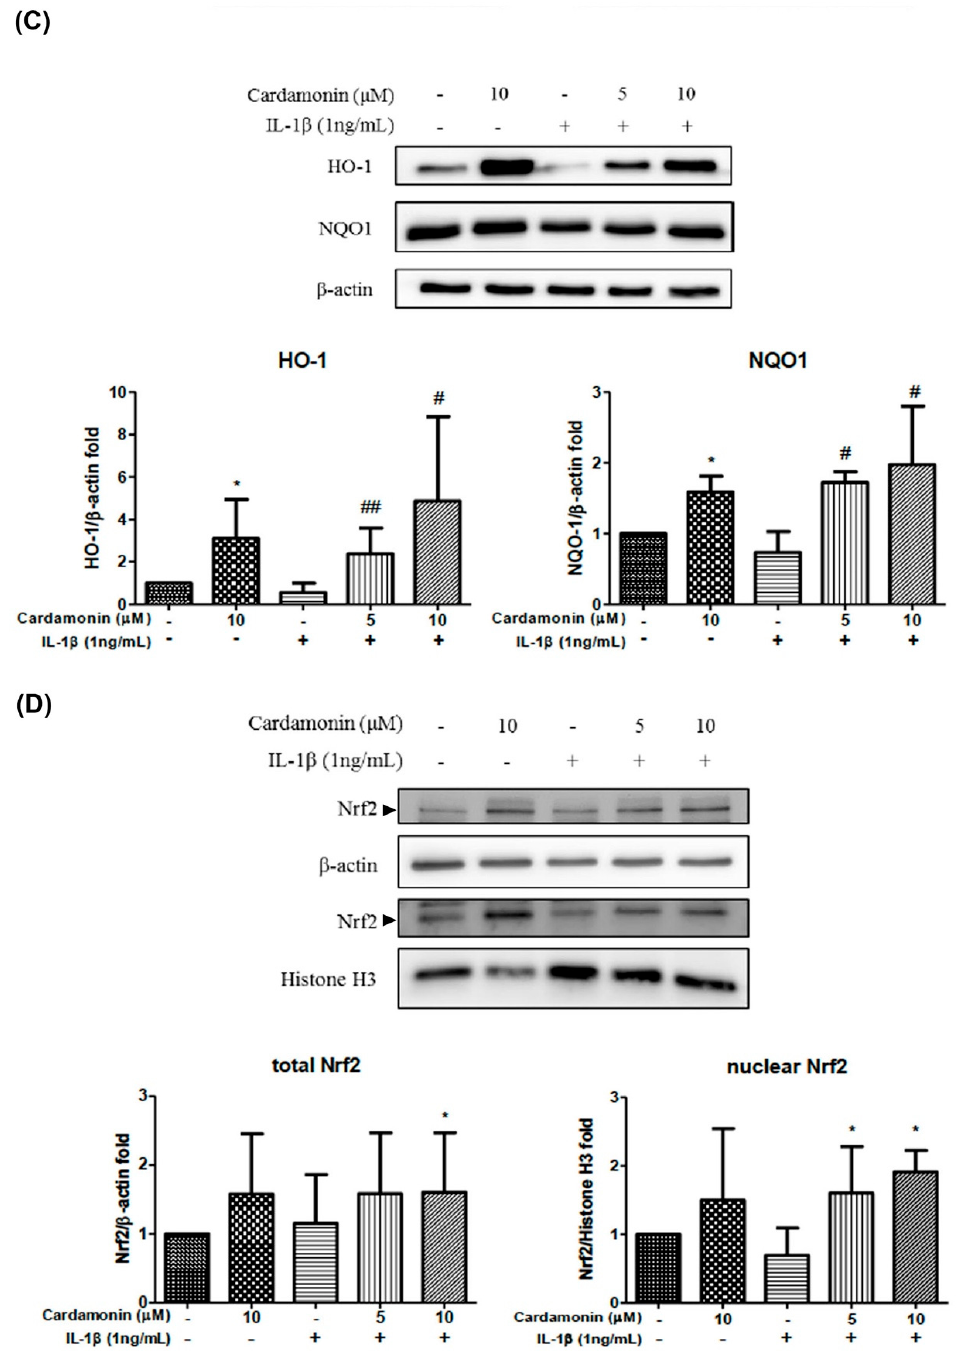
Figure 4. Effects of cardamonin on the activation of nuclear factor. ( A ) Protein samples from human OA chondrocyte cultures were detected using EMSA assays. ( B ) Chondrocytes were incubated with cardamonin at a concentration of 10 µ M for 24 h and then either stimulated with IL-1 β or not to detect protein expression levels of TLR2 and TLR 4 receptors. ( C , D ) Primary chondrocyte cells were incubated with cardamonin at a concentration of 10 µM for 24 h and then either stimulated with IL-1 β or not to detect protein expression levels of HO-1, NQO1, total Nrf2 and nuclear Nrf2. Specifically, we sought to examine the effects of cardamonin on protein expression levels of HO-1, NQO1, total Nrf2, and nuclear Nrf2 following IL-1 β treatment. All data comes from at least three independent experiments, and their significance were as follows: cardamonin group and the control group are indicated by an asterisk (*); significant differences between the cardamonin group and the IL-1 β group are indicated by a hash symbol (#). *, # p < 0.05; ## p <